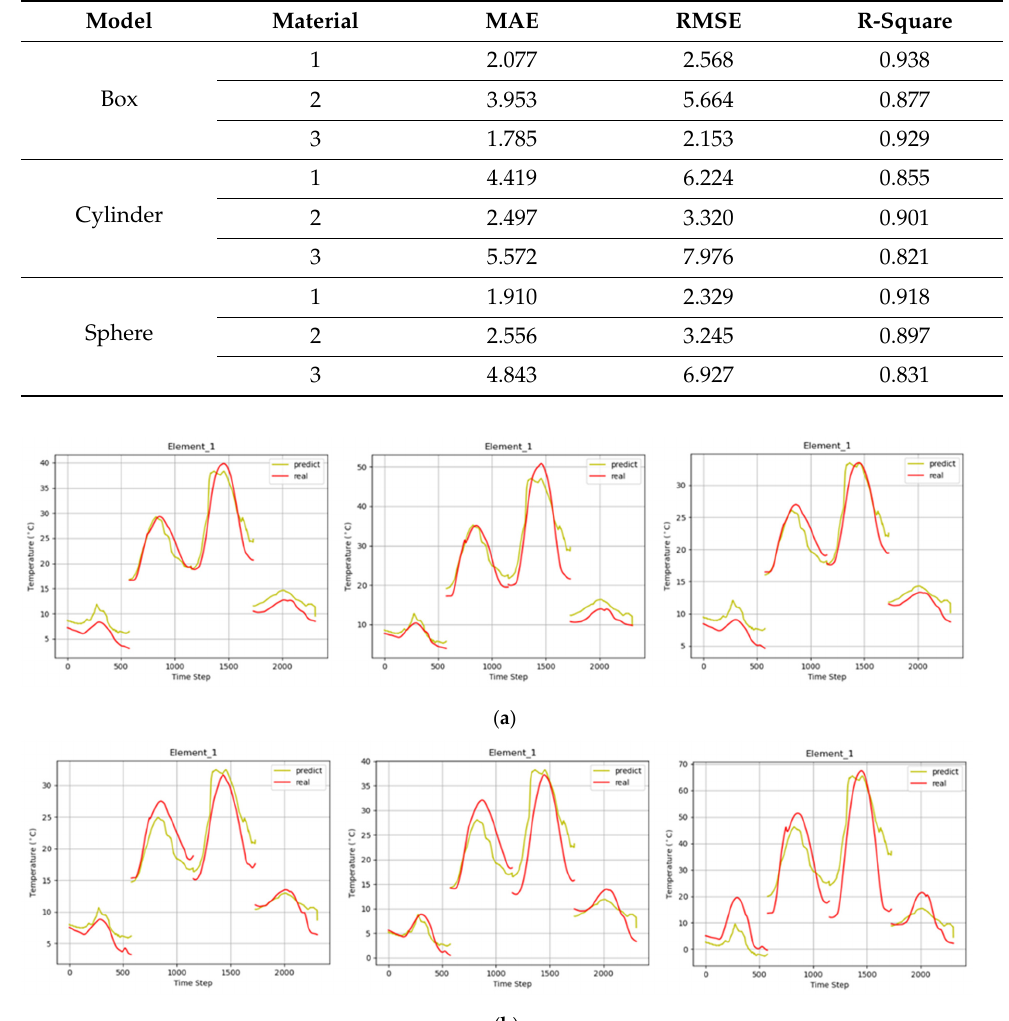
Table 3. MTPHNet’s generalization performance for multi-object temperature field prediction.